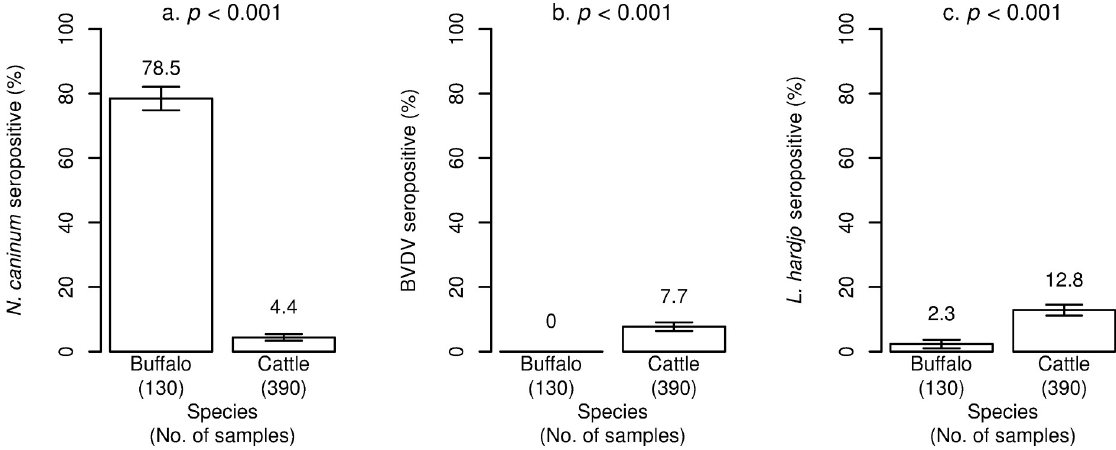
Fig 5. Prevalence of antibodies in cattle and buffalo identified by the enzyme-linked immunosorbent assays in 2018, Lao PDR. ( a) Neospora caninum , (b) bovine viral diarrhoea virus (BVDV) and (c) Leptospira interrogans serovar Hardjo ( L . hardjo